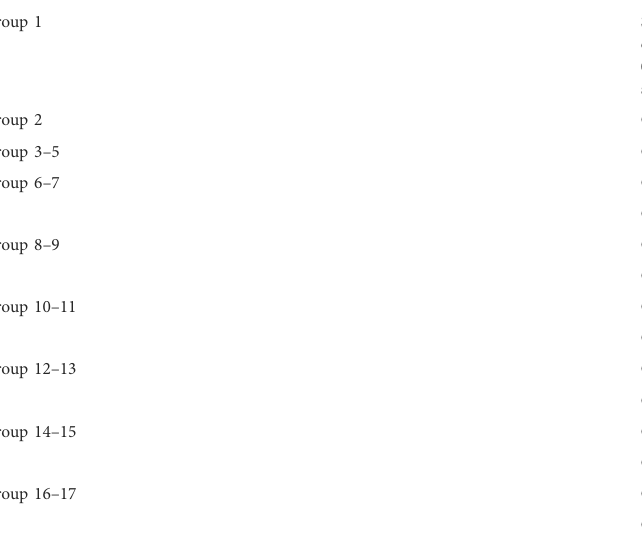
TABLE 1 Treatment groups animals were allocated into 17 study groups, by six rats in each group. Group 1 Sham group: without